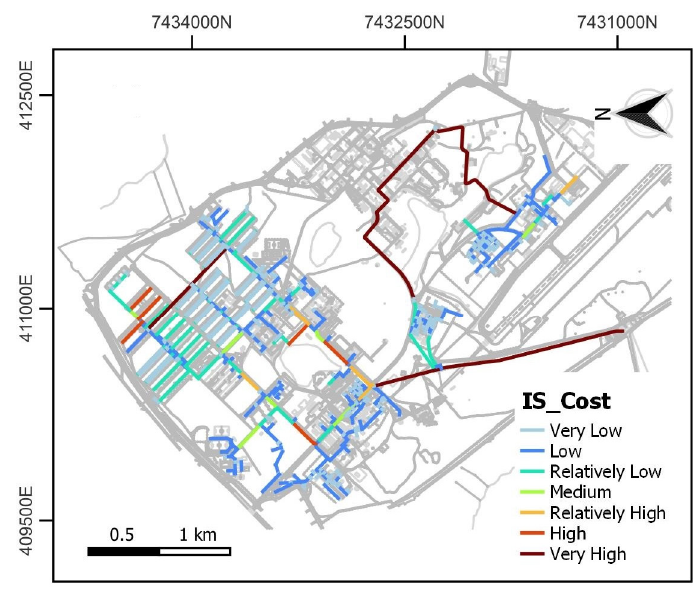
Figure 5. Financial consequence: pipe replacement cost.